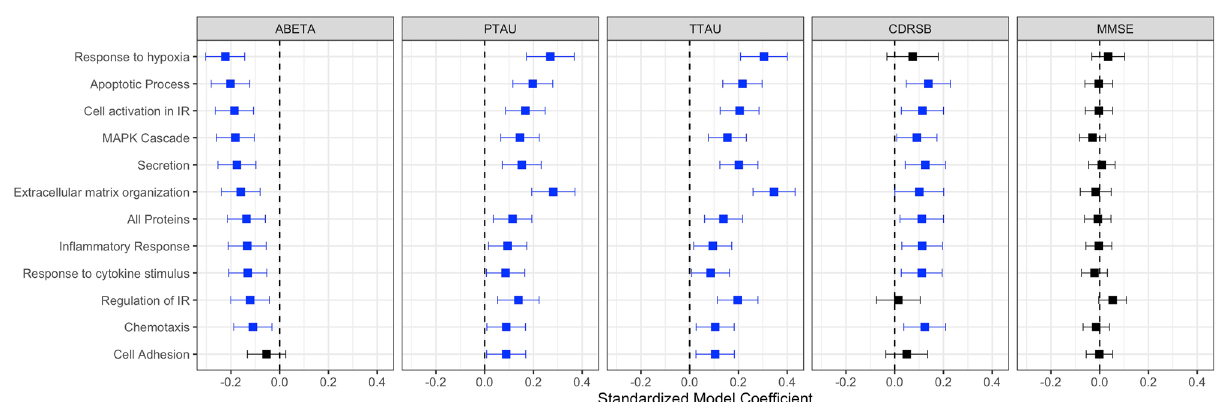
Figure 4. Association between CSF-based proteomic aging and core AD biomarkers. This figure shows the association between CSF-based InflammAGE scores (i.e. the difference between an individual’s inflammatory age and their chronological age) and various core biomarkers of AD—amyloid accumulation, tau accumulation, general neurodegeneration, and cognitive